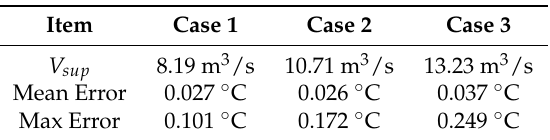
Table 3. Temperature error of reconstruction